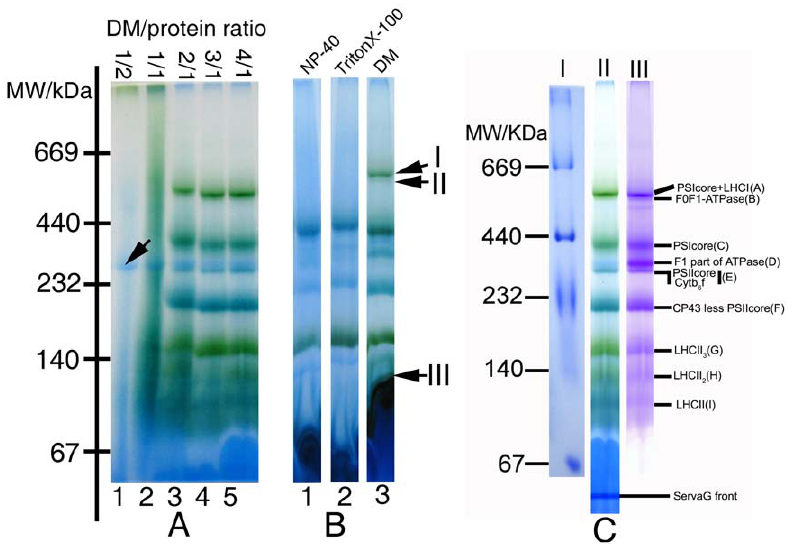
Figure 1. Pattern of thylakoid membrane complexes separated from rice by 1D BN-PAGE. A : The lanes 1, 2, 3, 4, and 5 were loaded with preparations of 50 m g chlorophyll( , 500 m g protein) dissolved in 50 m l of 0.5, 1.0, 2.0, 3.0, and 4.0% DDM lyses buffers. B : Each slot of lanes 1, 2, and 3 was loaded with the supernatants of 50 m g chlorophyll( , 500 m g protein) dispersed corresponding to 50 m l 4% NP-40, TritonX-100, and DDM lyses buffers. C : Lane I was loaded with high MW markers dissolved in 50 m L 4.0% DDM lyses buffers and electrophoresed in the same condition with Lane II. Lane II was loaded with the supernatant of 50 m g chlorophyll dispersed in 50 m L 4.0% DDM lyses buffers and scanned directly after electrophoresis, and lane III was the same as lane II and scanned after stained by Coomassie Blue, nine membrane complexes were labelled on the left of Coomassie- stained gel.